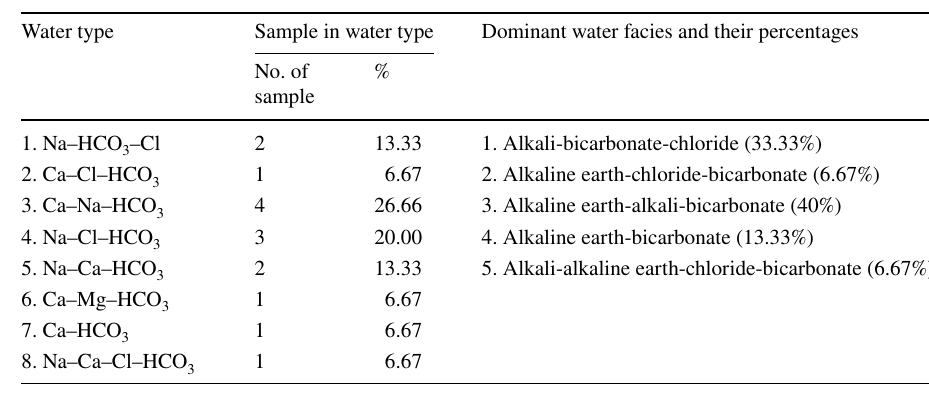
Table 4 Hydrogeochemical classifications of the water resources